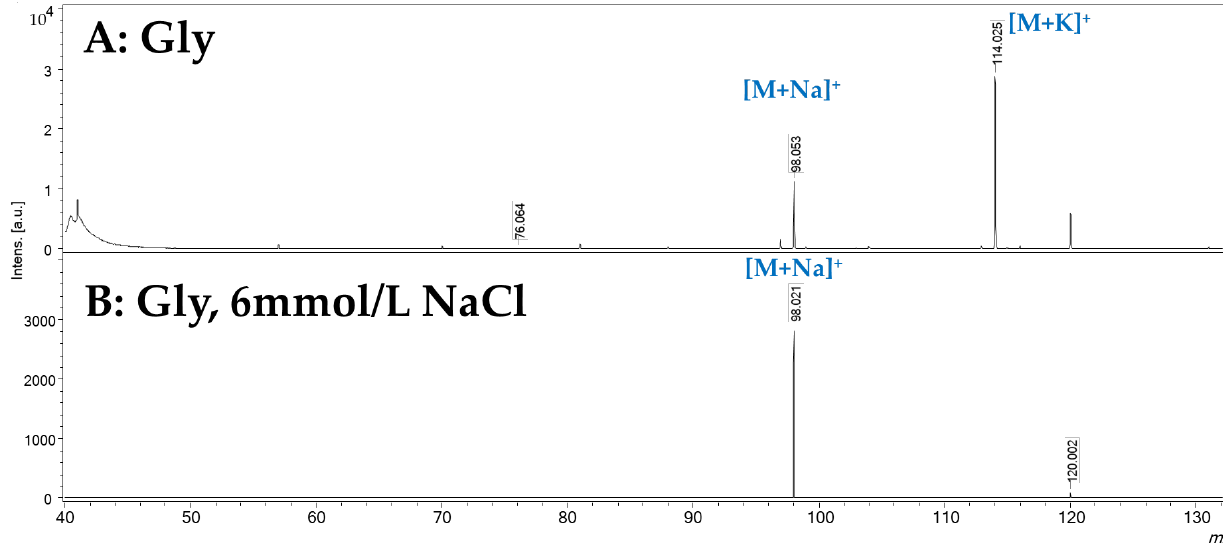
Figure 5. SALDI-MS spectrum, obtained in positive ionization mode by treating SWCNHs with a 6 mmol/L solution of NaCl. Panel ( A ): water solution of glycine (1 mg/mL). Panel ( B ): water solution of glycine (1 mg/mL).